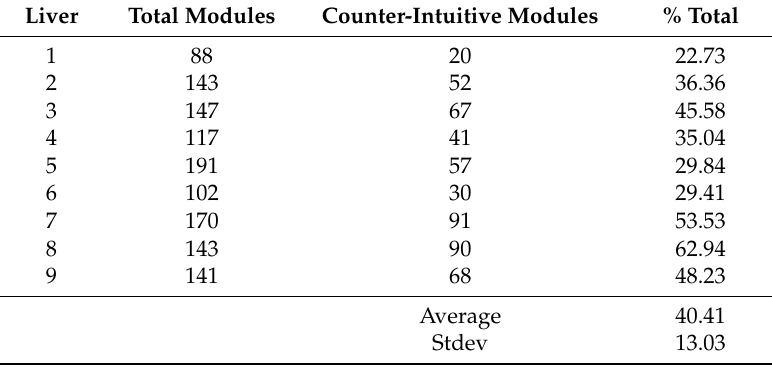
Table 3. For each liver, the number of modules satisfying the baseline criteria and the total number of ‘counter-intuitive modules’ are listed, the latter being defined as a module where no KEGG pathway exists with as many SSMs as contained in the module, suggesting that pre-defined textbook pathways insufficient capture the metabolic interaction. Liver Total Modules Counter-Intuitive Modules % Total 1 88 20